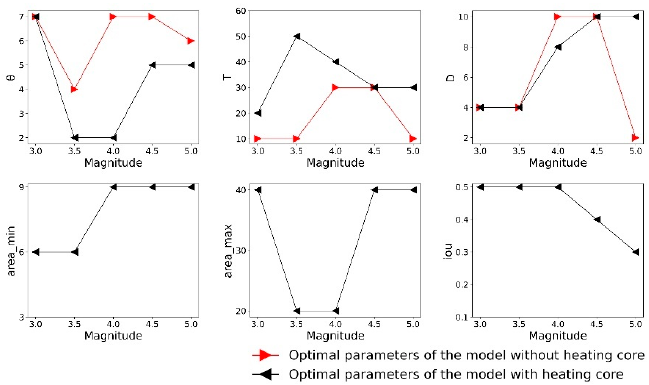
Figure 4. The optimal parameters of the models with/without the “heating core” when the resampling scale is 50 under different magnitude parameters; the red line indicates the change in the optimal parameters of the model without a “heating core”, while the black line indicates the change in the optimal parameters of the model with a “heating core” (the same below).